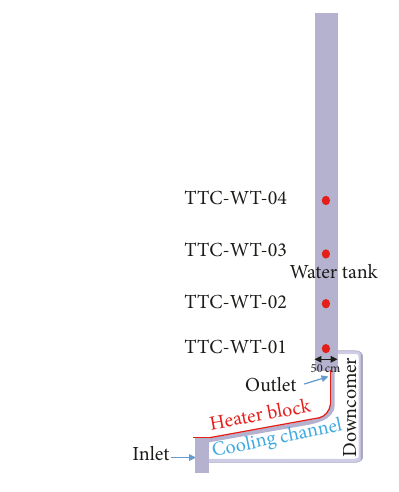
Figure 7: Total power to the heating blocks for Case 4-1. Figure 8: Temperature measurement locations in the water